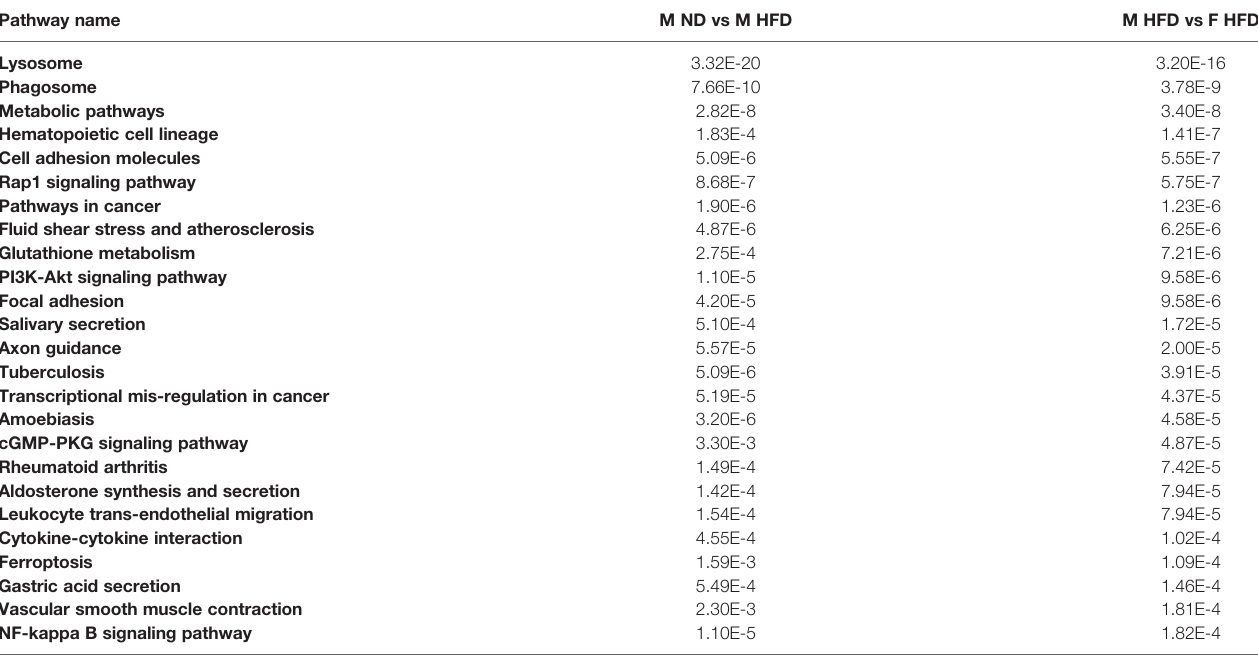
TABLE 1 | P-value for top biological pathways after FDR sorting for M HFD vs F HFD and M ND vs M HFD. Pathway